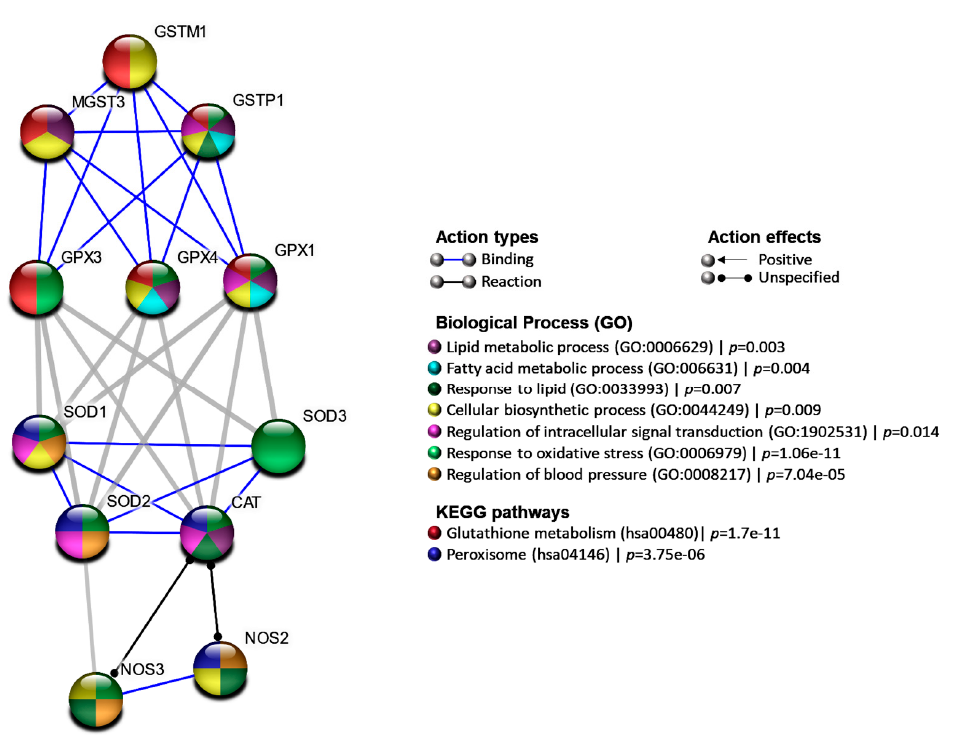
Figure 3. Protein–protein interaction network. Nodes represented the genes colored according to the functional enrichment pathways and biological process, while edges showed interactions. STRING database version 11.0 was used. As a member of phase II drug metabolism-related family catalyst, GSTM1 can detox- ify the electrophilic products generated from lipid peroxidation that considers one of the major pathogenic cellular changes in obesity onset and progression [63]. Although Yang, [64] did not find an association of GSTM1 rs1056806 (c.528C > T) polymorphism with sus- ceptibility of obesity in the Korean cohort (117 overweight/obese cases versus 125 non- overweight/obese subjects), a higher frequency of the heterozygous genotype was evident